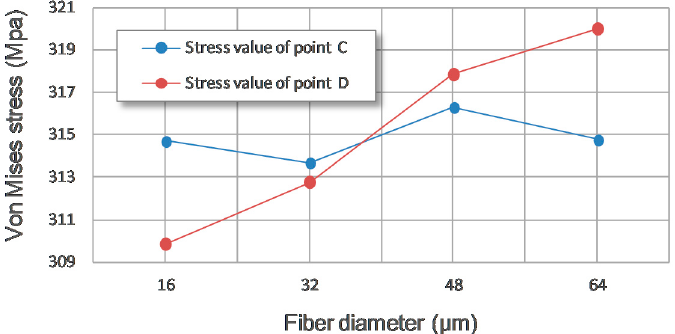
Figure 19. Stress magnitude at point C (the maximum stress value of the stress concentration region) and point D (the maximum stress value on the side of the center SiC fiber) for the four stress fields with an increasing SiC fiber diameter.